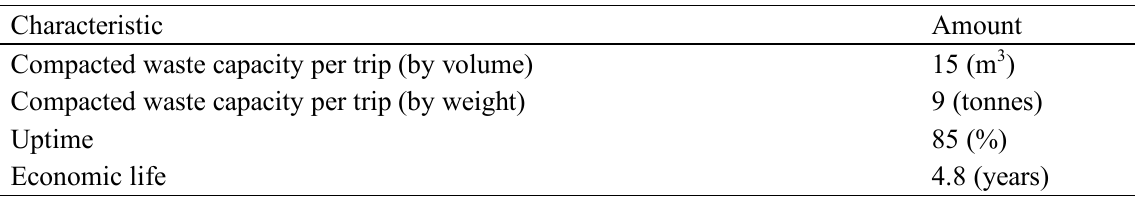
Table 5. Characterization of SWCTT vehicles